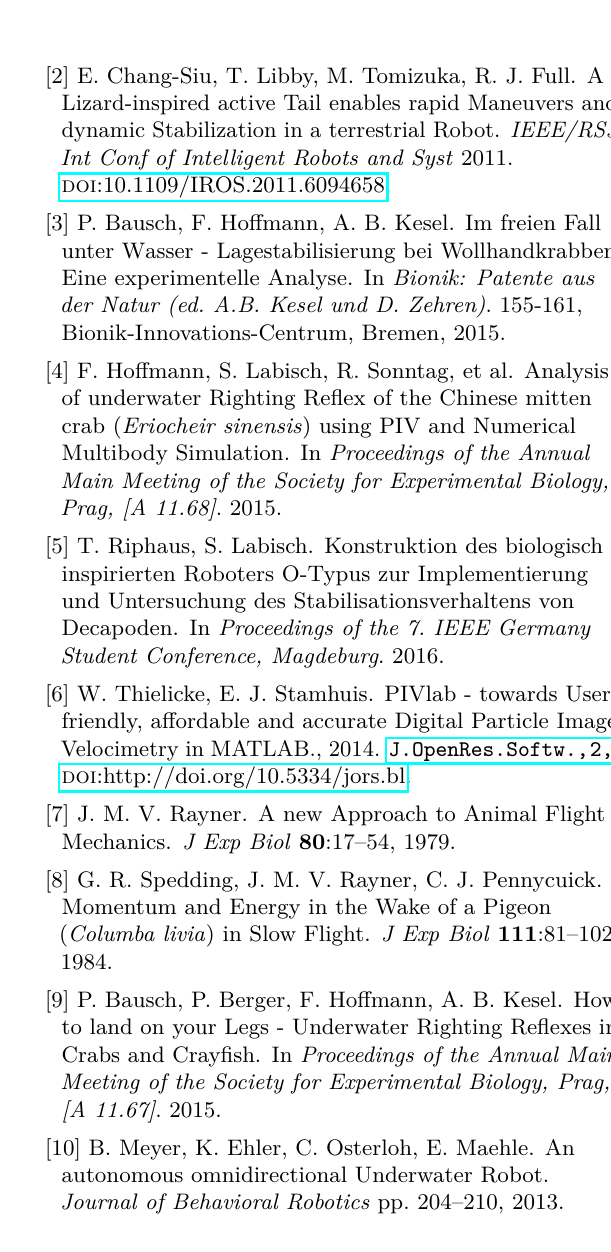
Table 1. Summary of relevant parameters regarding the turning of E. sinensis , its numerical model and its technical application. Values of the measured force are mean values during the striking phase 2a. The angular velocity is the averaged value of the whole turn.